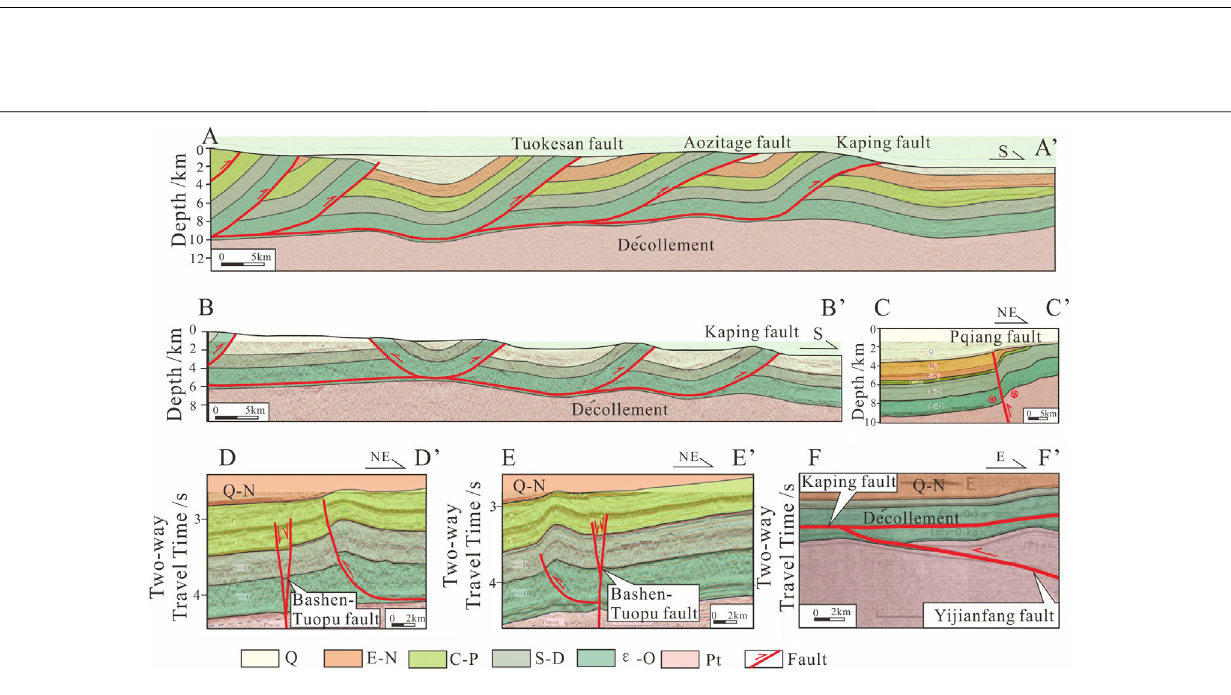
Frontiers in Earth Science |